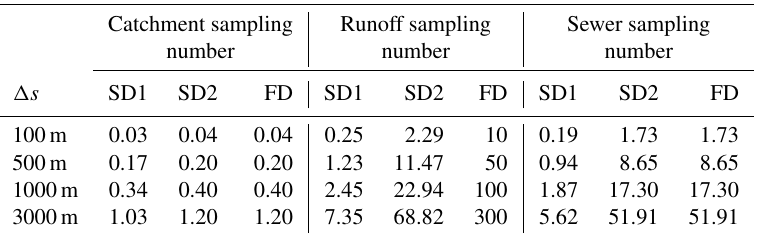
Table 7. Dimensionless parameters for the three models used in this study, based on Bruni et al. (2015), used to describe the interaction between spatial rainfall resolution and model